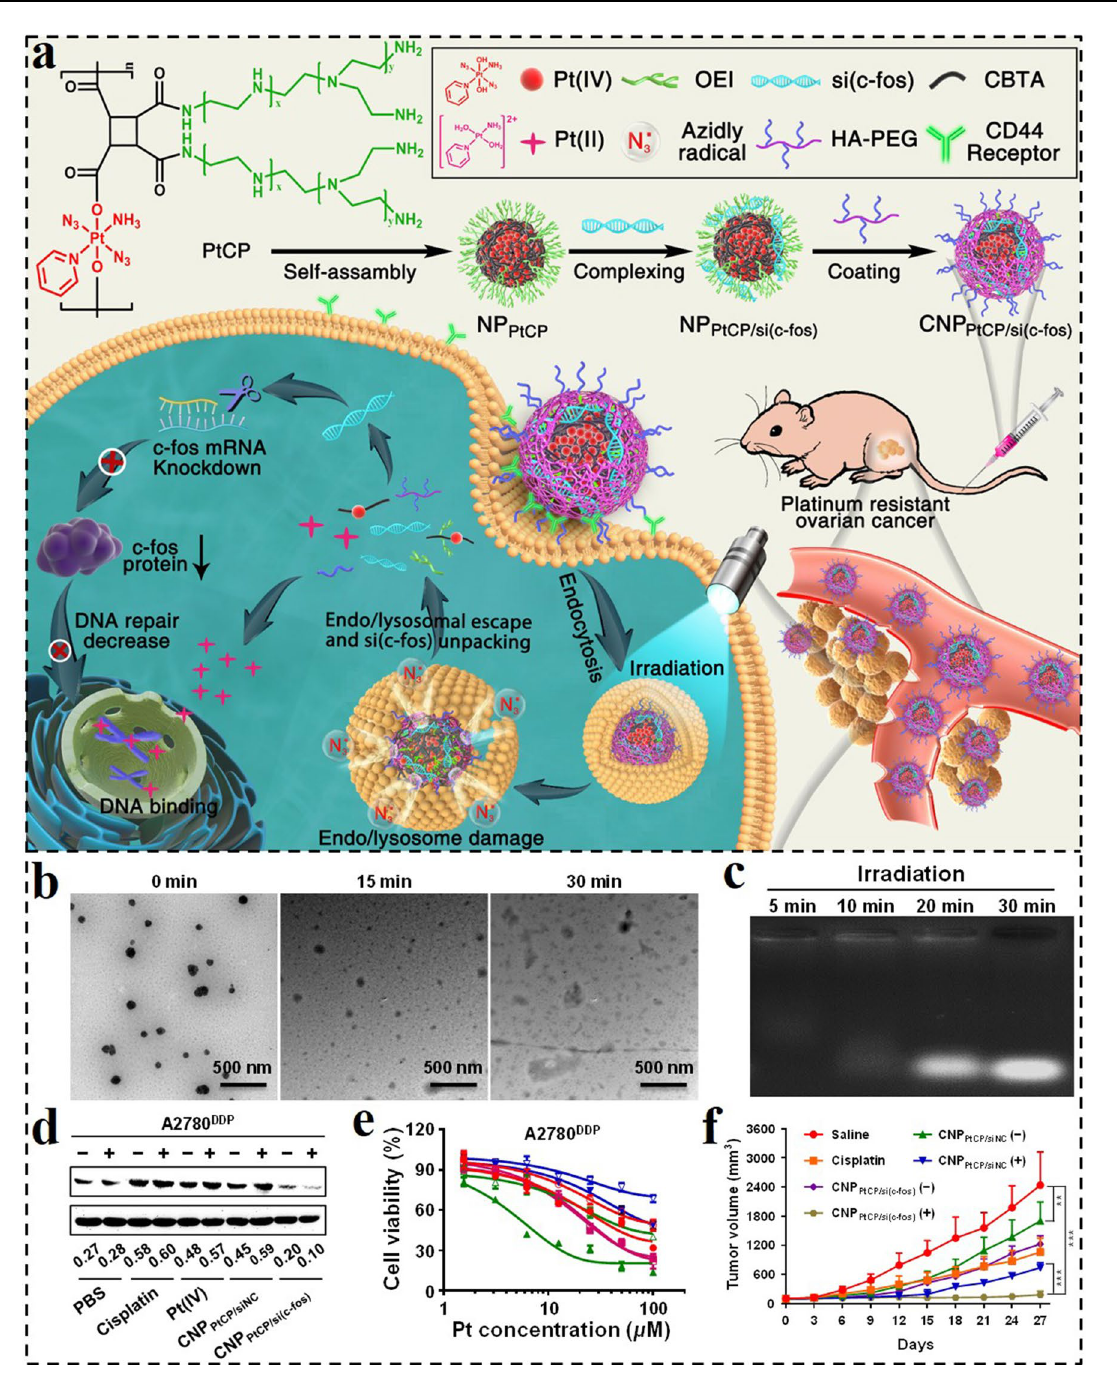
Fig. 12 a Schematic illustration of the photoactivatable Pt(IV) prodrug-backboned polymeric nanoparticle system (CNP PtCP/si(c-fos) ) for light- controlled efficient gene delivery and synergistic chemotherapy and RNAi on PROC. b Morphology changes of CNP PtCP/si(c-fos) after irradiation for different time intervals. c Photo-responsive dissociation of CNP PtCP/si(c-fos) after irradiation for different time intervals. d c-fos protein expres- sion levels of A2780 DDP cells after different treatments. e Cell viability curves of A2780 DDP after incubation with different drugs for 72 h with or without irradiation. f Tumor volume changes of mice during the experiment [174]. Copyright 2020, American Chemical